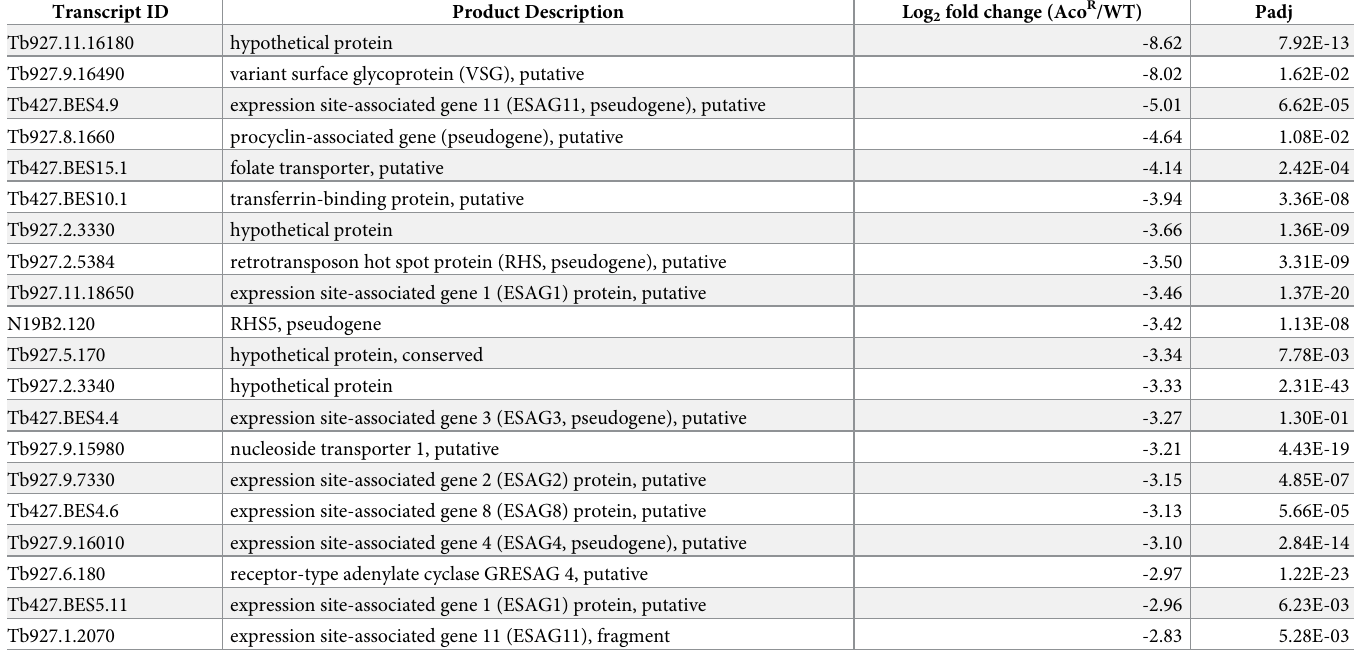
Table 2. Top 20 genes with significantly decreased abundance in Aco R cells. Only one example shown for repeated genes. For full results see S1